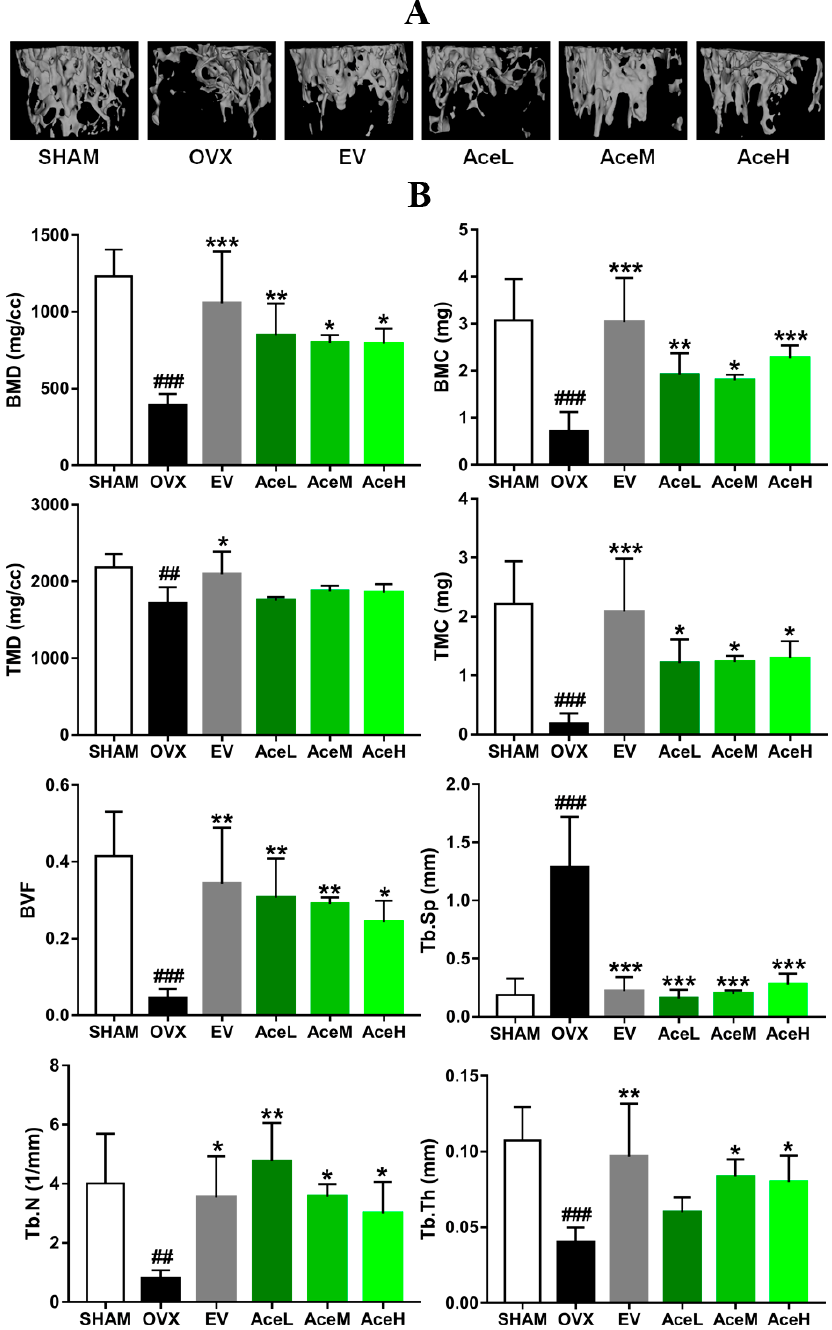
Figure 3. Acteoside treatments effectively prevented OVX-induced deterioration of trabecular microarchitecture in femur. ( A ) Right femur of mice from different groups were analyzed by micro-CT scans ( n = 4), the trabecular area and trabecular number were significantly decreased in the OVX mice. After 12 weeks of treatment with acteoside and EV, the OVX-induced bone loss was partially prevented, and the microarchitecture was slightly improved. ( B ) Effects of acteoside and EV on OVX-induced microarchitecture changes. Microarchitecture parameters were described as bone mass density (BMD), bone mineral content (BMC), tissue mineral density (TMD), tissue mineral content (TMC), bone volume fraction (BVF), trabecular separation (Tb.Sp), trabecular number (Tb.N), and trabecular thickness mineral (Tb.Th) ( n = 4). Values were presented as the mean ± SD; * p < 0.05, ** p < 0.01, *** p < 0.001 relative to the mice of OVX model group; ## p < 0.01, ### p < 0.001 relative to the SHAM group.